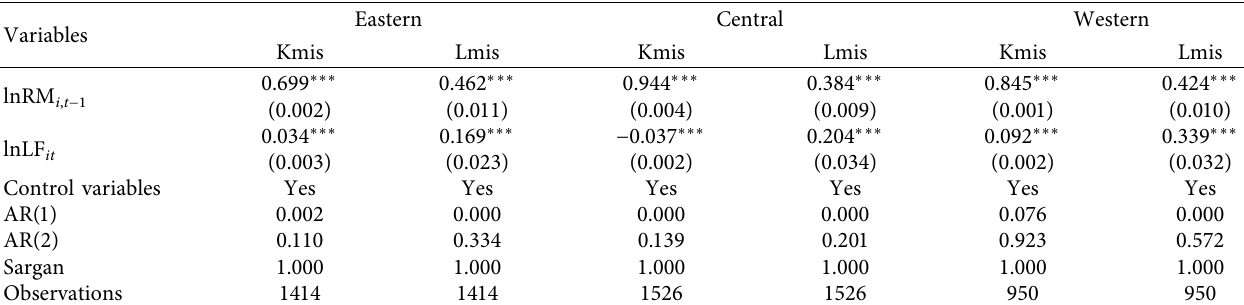
Table 4: Estimation results for the regional sample based on the SYS-GMM